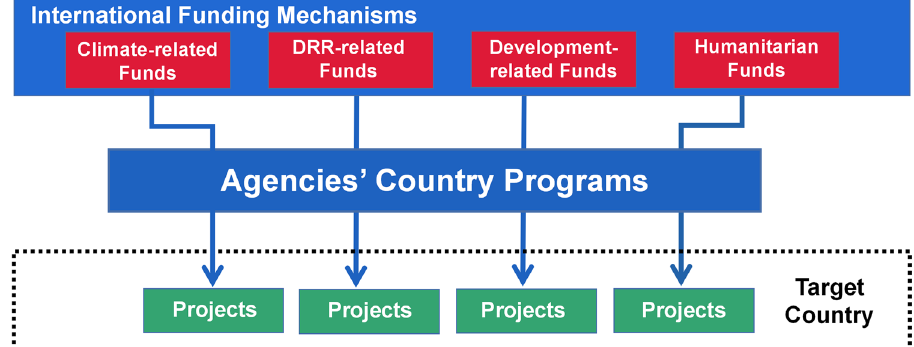
Fig. 6 A scheme showing inter- national funding mechanisms for target